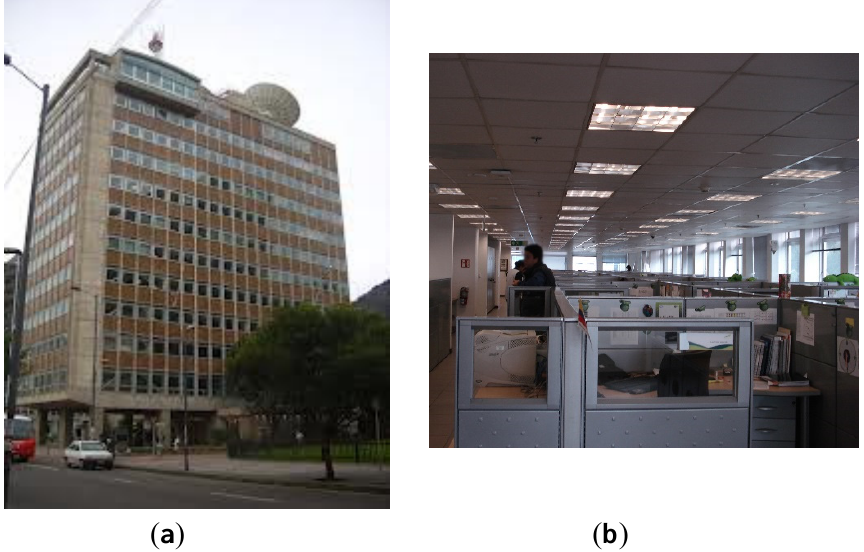
Figure 10. ( a ) External and ( b ) internal views of a typical commercial office building in Bogotá. Source: